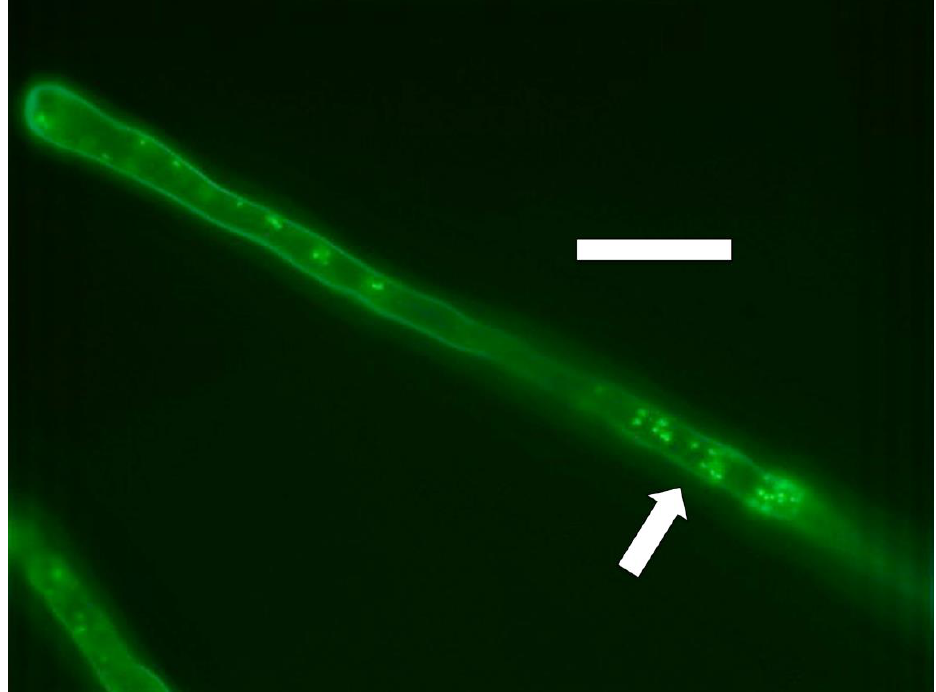
Figure 9. Poa reptans seedling root hair showing nitric oxide (green fluorescence; arrow) staining around and within cells of Bacillus amyloliquefaciens stained with diaminofluorescein (DAF; bar = 30 µm).